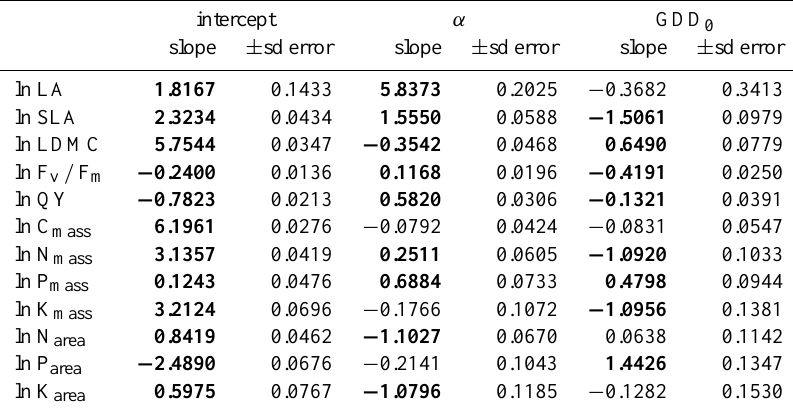
Figure 4. Partial residual plots for the relationships between leaf traits and growing degree days (GDD 0 ) , from the GLM analysis summarized in Table 2. Each point denotes a species-site combination; PFTs are indicated by colours. Only significant regression slopes ( P <0.01) are shown. Table 2. Regression coefficients for the GLM with only α and GDD 0 as predictors. Values in bold are significant at P